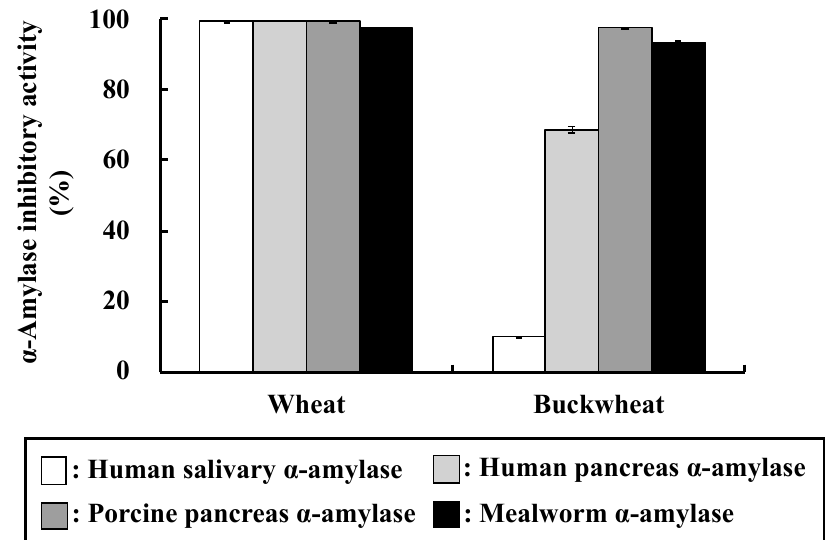
Figure 1. α -Amylase inhibitory activity of wheat and buckwheat α -AIs. Each value is the mean of three experiments with standard error (S.E.) shown as a vertical bar.